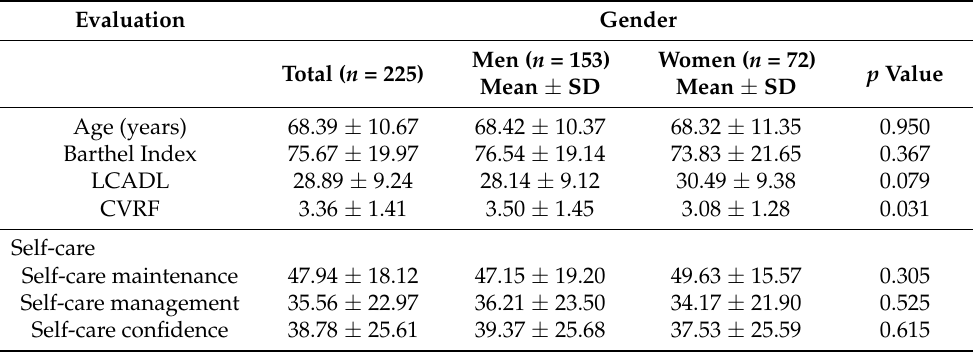
Table 1. Comparison of the patients according to